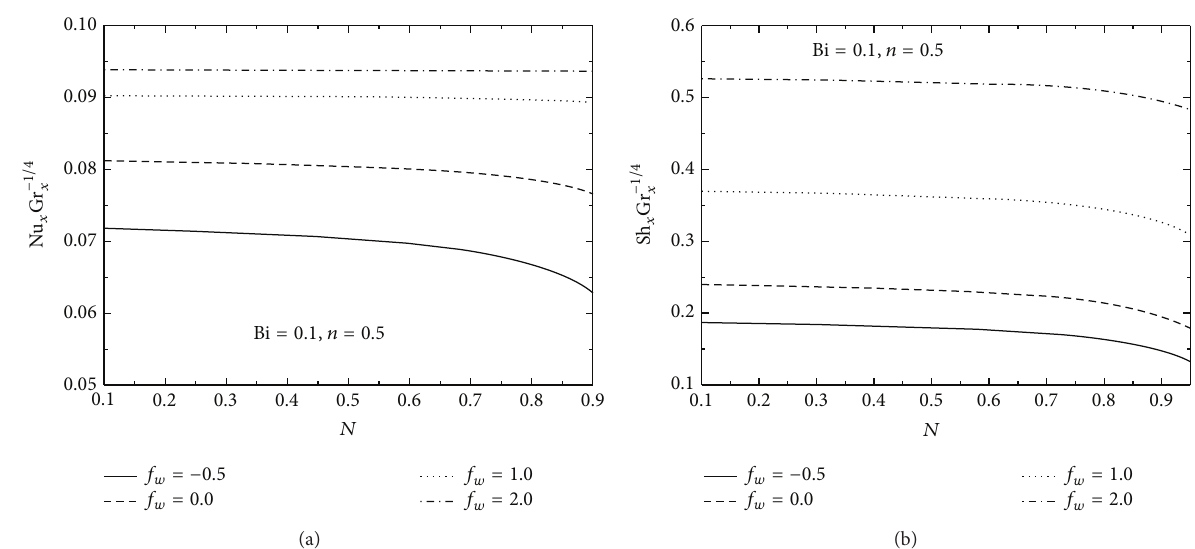
Figure 7: Effect of 𝑓 𝑤 on (a) heat transfer rate and (b) mass transfer